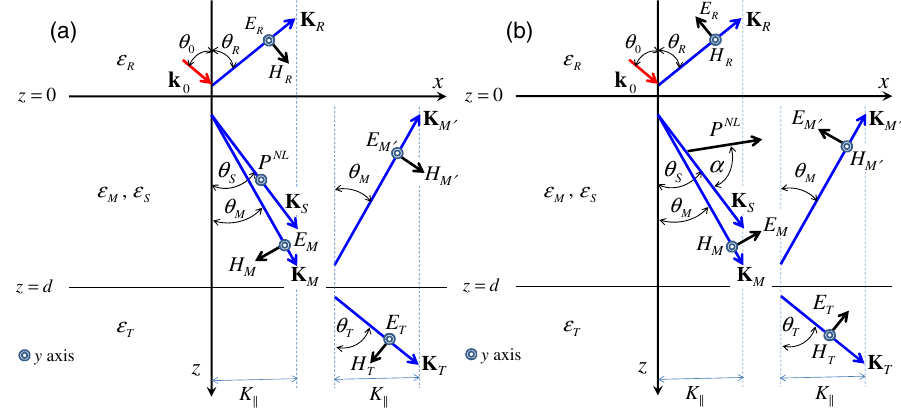
FIG. 1. Geometry of harmonic fields and nonlinear polarization arising from a slab of nonlinear material for (a) s and (b) p is also shown for polarizations. The fundamental wave vector k 0